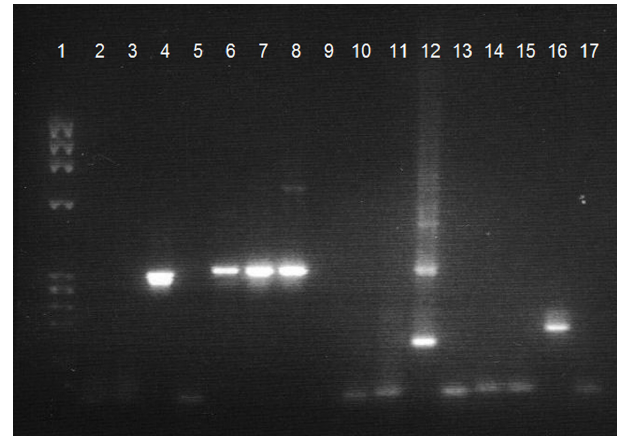
Figure 6. 1: Molecular marker (PhiX174/HaeIII); 2, 3, 6, 7, 10, 11, 14, 15: blood of the dog; 4: T. congolense savannah-type positive control; 8: T. congolense forest-type positive control; 12: T. vivax positive control; 16: T. brucei positive control; 5, 9, 13, 17: negative